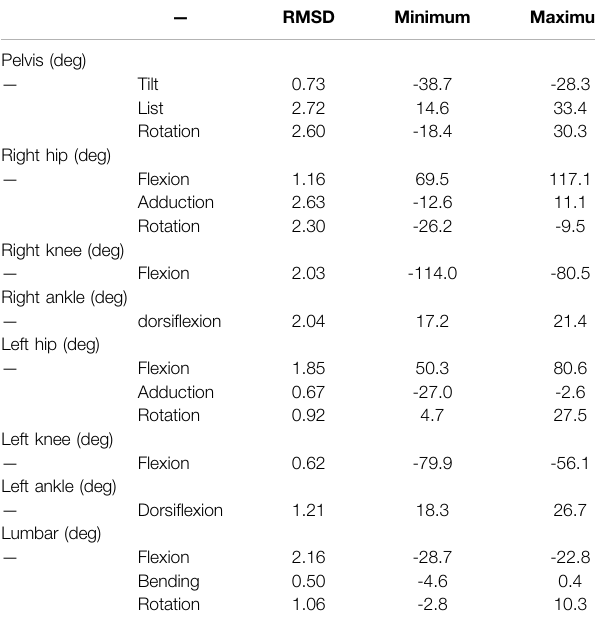
TABLE 1 | Root mean squared difference (RMSD) between the measured joint angles of the skier during the turning maneuvers and the corresponding joint angles ofthemusculoskeletalskier model inthe tracking simulation. Minimum and maximum values of the joint angles of the skier during the turning maneuvers are reported, additionally.